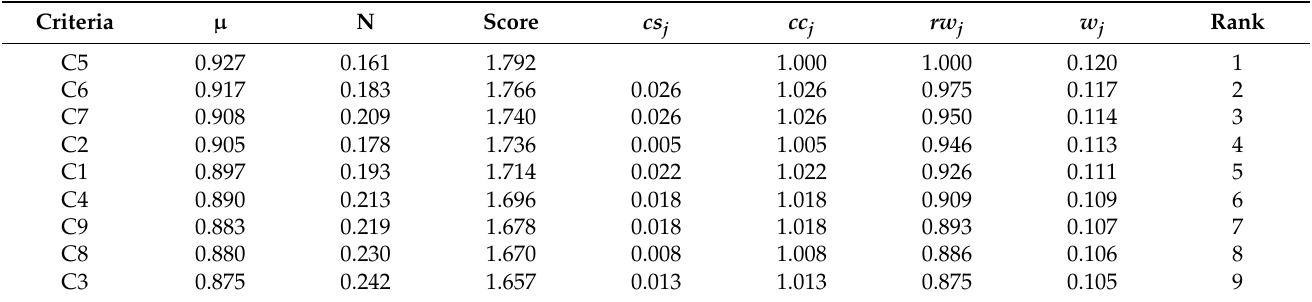
The aggregated evaluations of DMs and results of FF–SWARA are presented in Table 9. Table 9. The results of FF–SWARA.